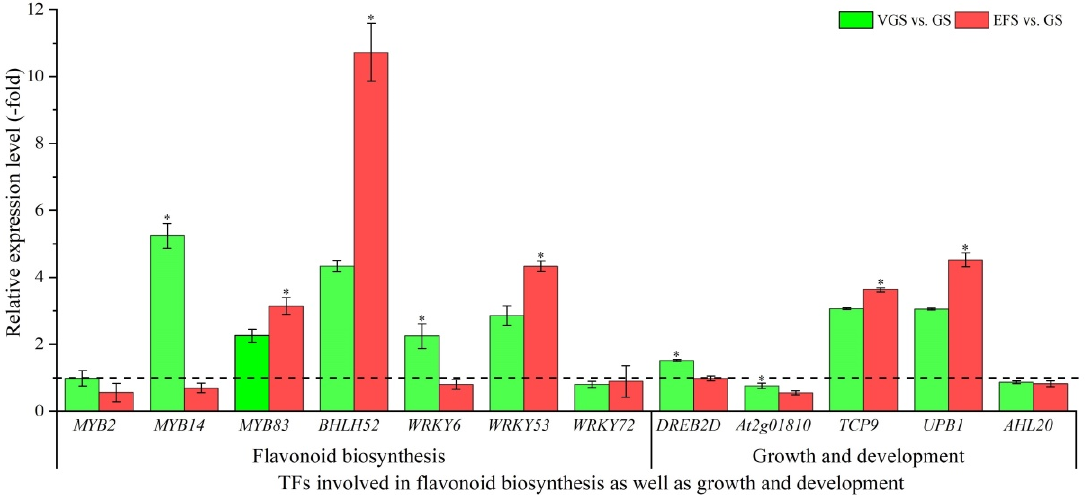
Figure 10. The relative expression level of TFs involved in flavonoid biosynthesis as well as growth and development at VGS and EFS vs. GS, as determined by qRT-PCR (mean ± SD, n = 3). The “*” represents a significant difference ( p < 0.05) at different growth stages for the same gene.